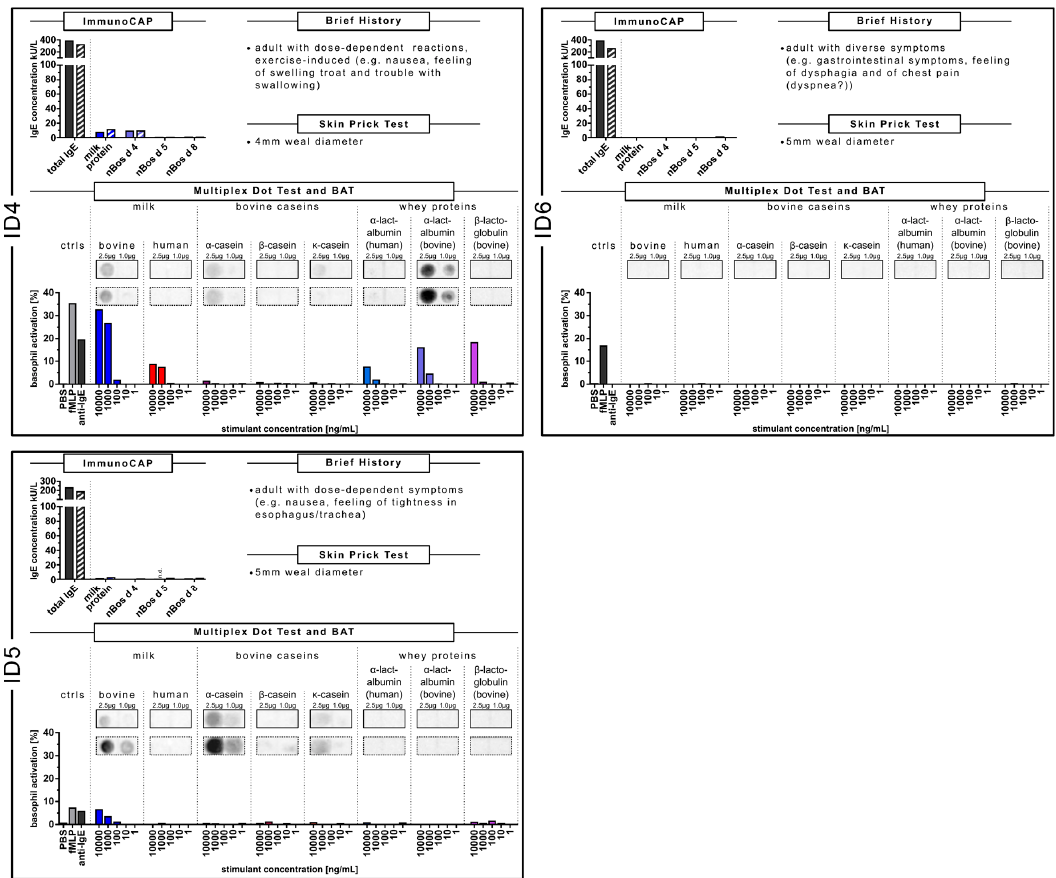
Figure 2. Synopsis of data of the sensitization pattern of ID4, ID5 and ID6 with milder allergic reactions in the ImmunoCAP, multiplex dot test and BAT. Whey proteins were more pronounced with this clinical response. CAP data of the CMA patients were depicted in a bar graph. The filled bars show the data of the first blood sample, the hatched bars are those of the second blood sample. Determination of IgE recognition to whole and single allergens of cow’s milk and human milk in the multiplex dot test. The concentration of the dot-blotted analytes as indicated was 1.0 µ g / µ L and 2.5 µ g / µ L, respectively. The IgE recognition of the first blood sample was given in a box with a solid line, of the second blood sample with a box with a dotted line. The BAT was performed with blood of the patients using whole cow’s milk and human milk and single bovine and human milk allergens. Percentages represent CD63 positive basophils determined by flow cytometry. Blood sample stimulation was conducted with the analytes as indicated. fMLP, anti-IgE were run as positive controls, PBS as negative